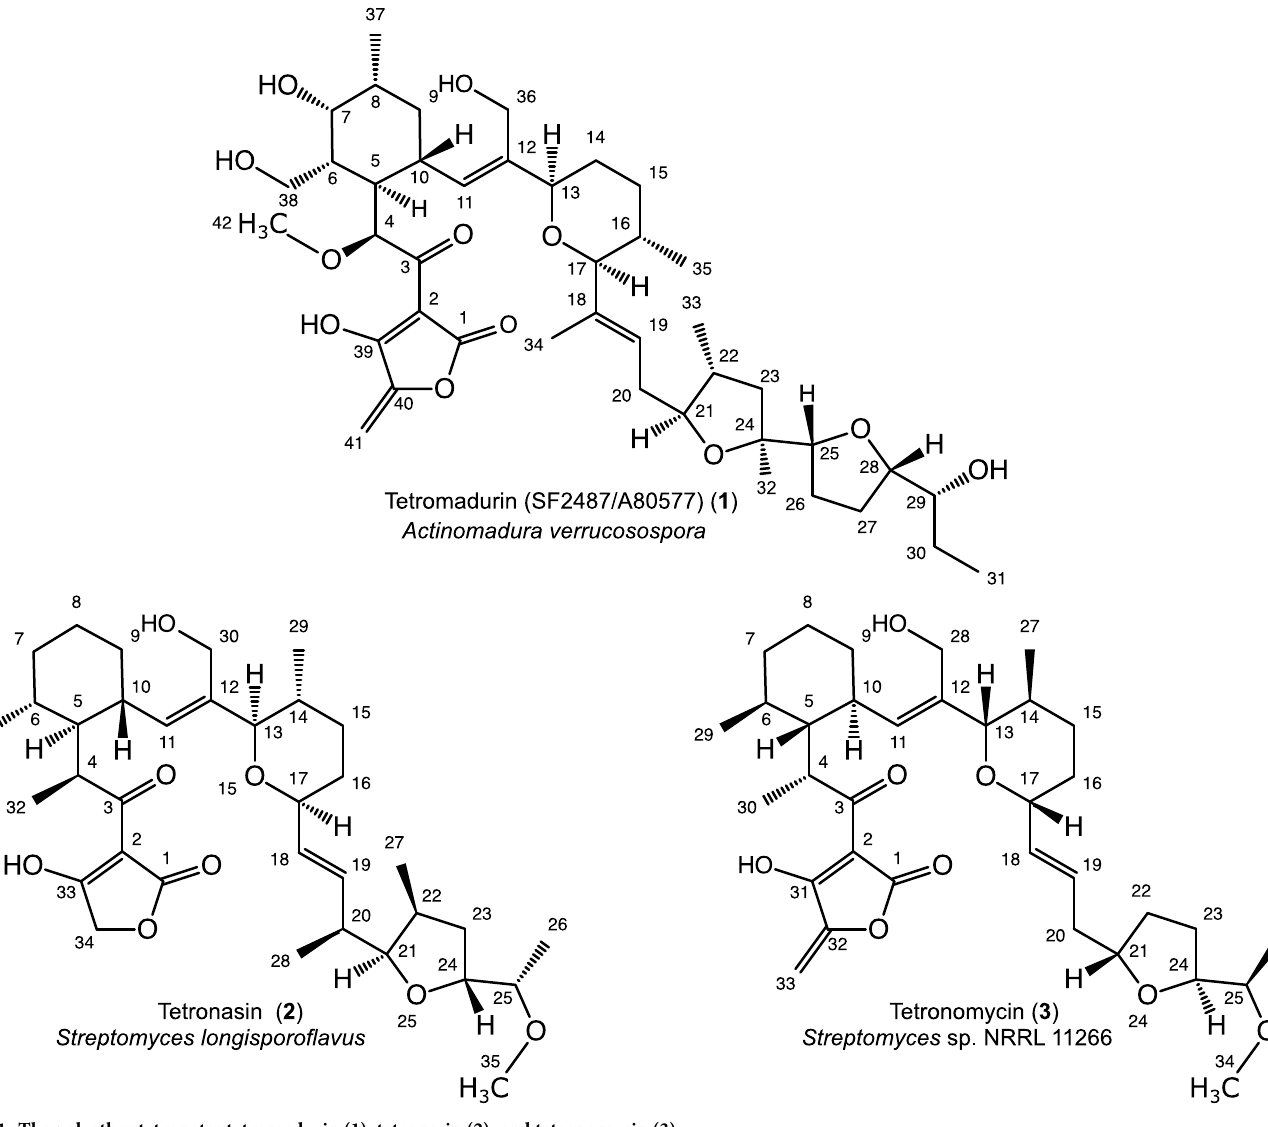
Fig 1. The polyether tetronates tetromadurin (1), tetronasin (2), and tetronomycin